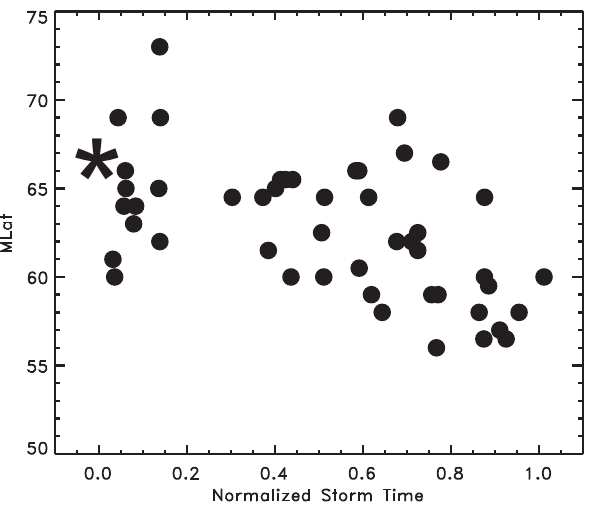
Fig. 5b. ILat locations of localized onsets as a function of Sym- H at the time of event onset. Asterisk indicates the average onset location for isolated